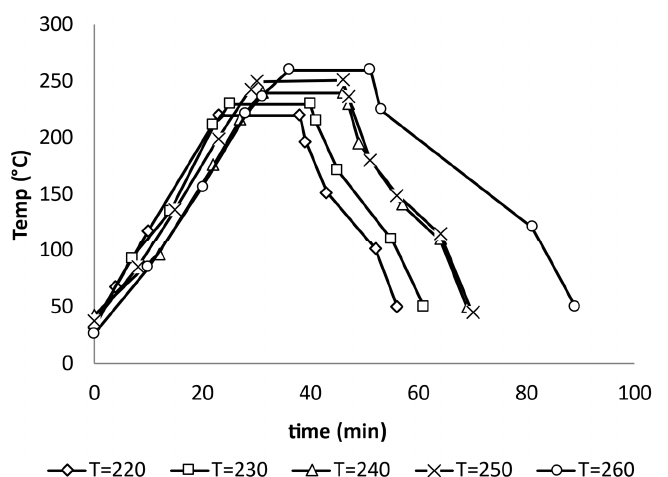
Figure 1. Reaction heating and cooling pathways delivered by the reactor at different temperatures. There was no difference between tests using CO 2 and N 2 . Set temperatures (°C) were: ⬦ , 220; □ , 230; △ , 240; X, 250; Ο , 260. Heating pathway is based on average values from two experiments, with variation between replicates within ±5%. The conversion of cellulose (X c, %) into products under N 2 and CO 2 is shown in Figure 2a,b, respectively, increasing exponentially with respect to temperature.